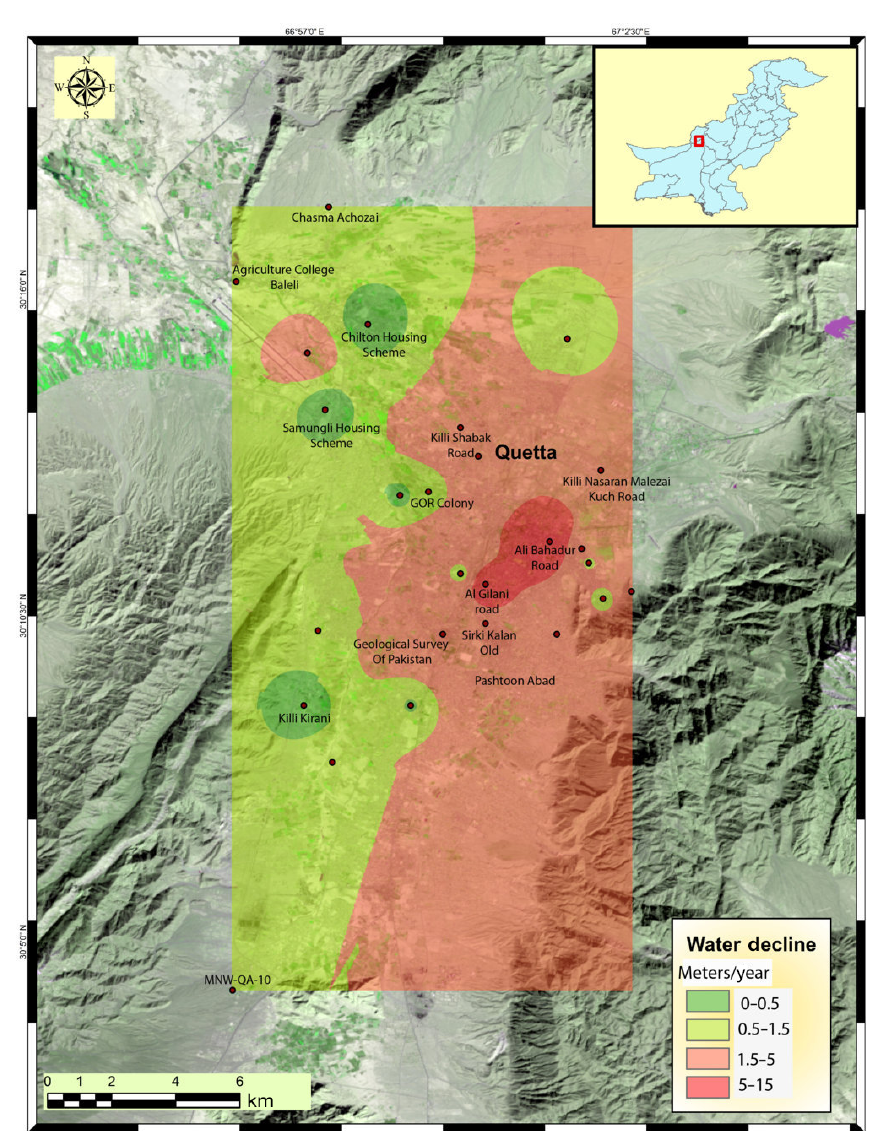
Figure 7. Map of water decline in Quetta valley. The red and dark red color show the water decline of 1.5–15myr − 1 whereas, the green and dark green color show the water decline of 0–1.5myr − 1 . 30m Digital Elevation Model (DEM) of Shuttle Radar Topographic Mission (SRTM) were downloaded from ©NASA’s Earth Explorer website to identify the topography and profile of the study